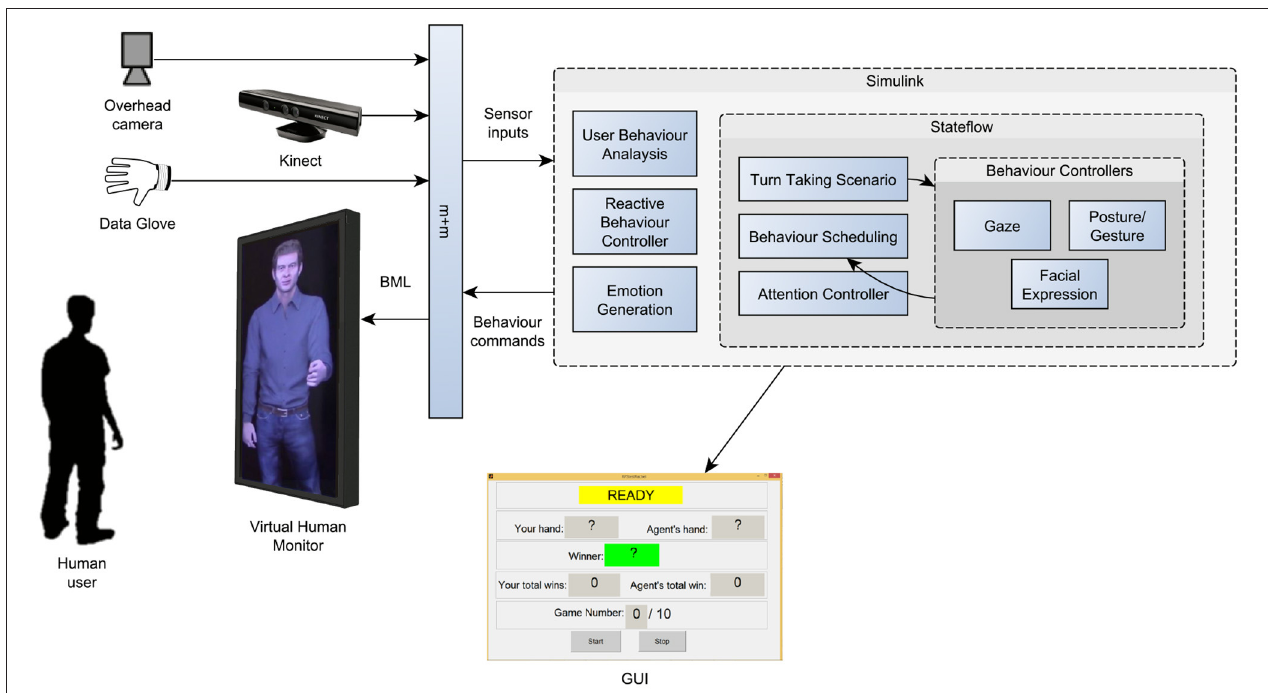
FIGURE 6 | Implementation of the model as a real-time interactive system. The continuous control model is implemented using Simulink. The Stateflow component realises the finite state machine for event-based control. The model receives sensor data and sends control signals to the Virtual Human using the “Movement + Meaning” (m+m) middleware ( Bernardet et al.,